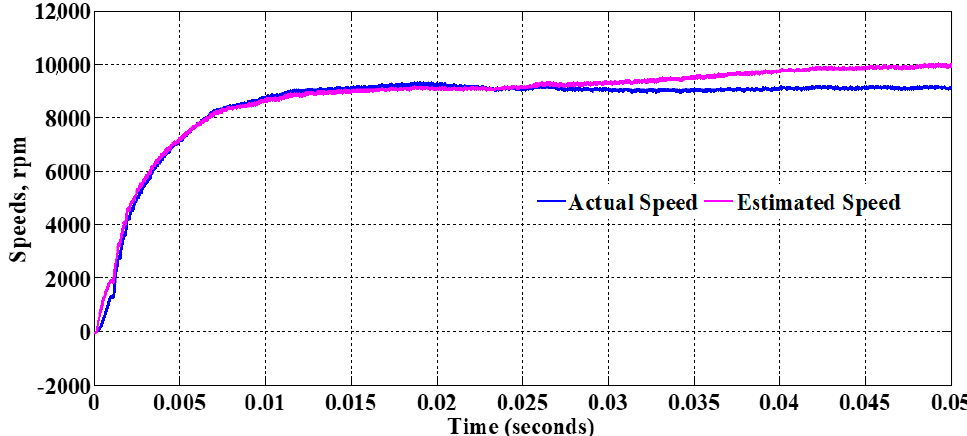
Figure 17. Estimated and actual speeds.